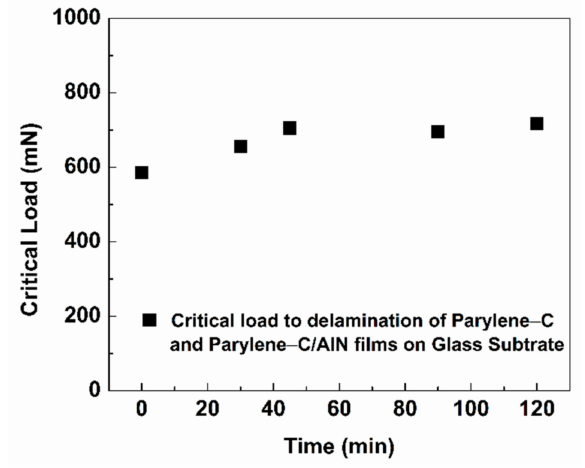
Figure 7. The critical load to delamination comparison of pristine parylene-C and parylene-C/AlN films, with respect to sputtering